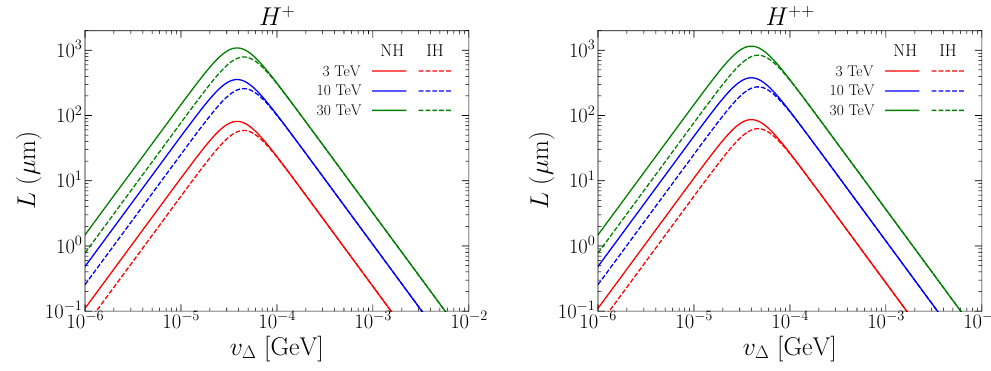
Figure 5 . The decay length of singly charged Higgs H + (left) and doubly charged Higgs H ++ (right). The c.m. energy is taken to be